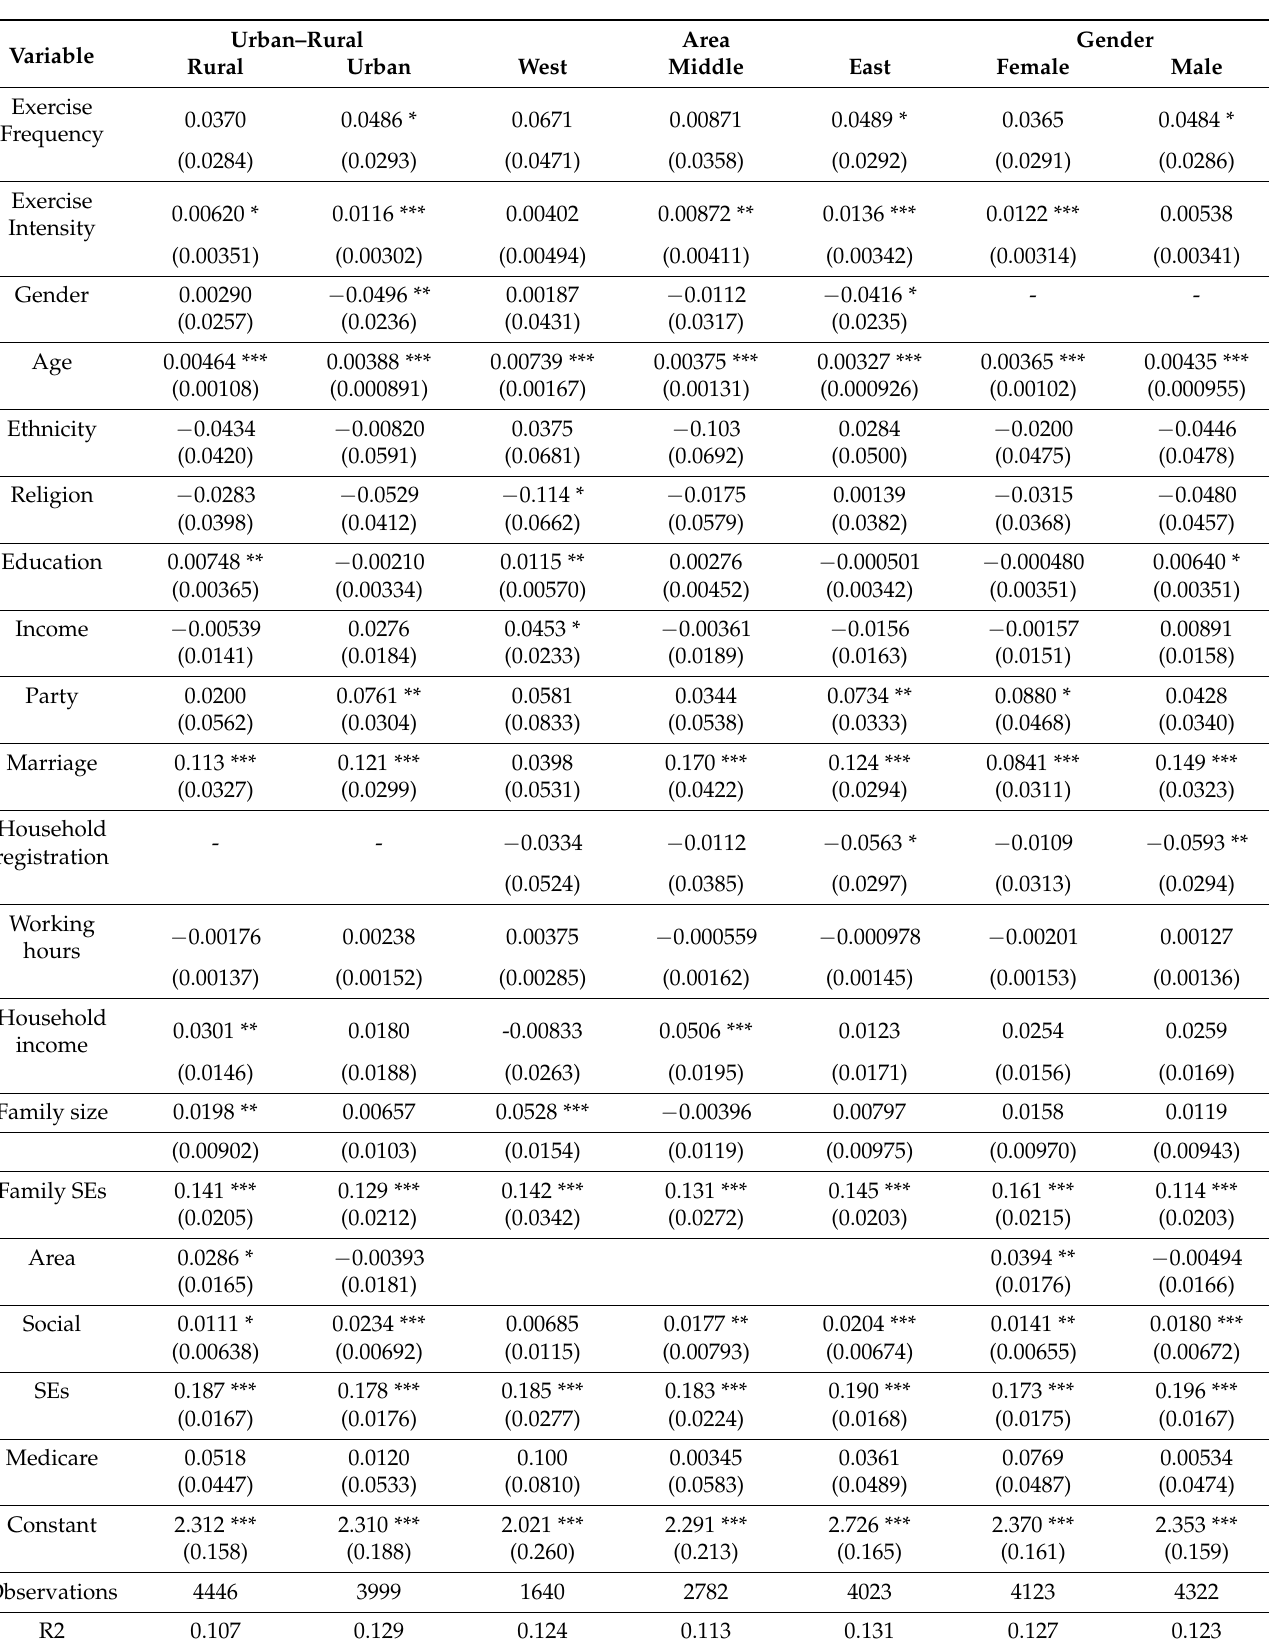
Table 3. Grouping regression